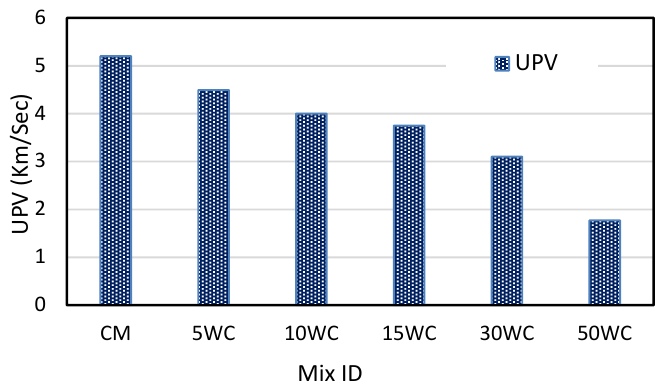
Figure 8. Ultrasonic pulse velocity results.